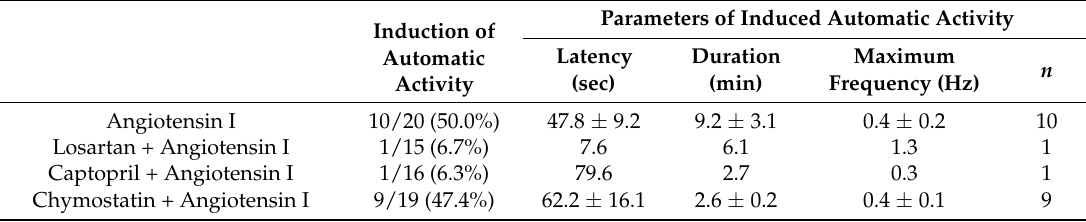
Figure 2. Induction of automatic contractile activity by angiotensin I in pulmonary vein tissue preparations. ( A ) Typical contractile records on application of 1 μM angiotensin I alone (a), in the presence of 10 μM losartan (b), in the presence of 1 μM captopril (c), in the presence of 10 μM chymostatin (d); ( B ) Summarized time course of the frequency of contraction induced by 1 μM angiotensin I. The 0 min on the time scale indicates the onset of contractile activity. Symbols and vertical bars indicate the mean ± S.E.M. from 8 experiments; ( C ) Summarized results of the rate of induction of automatic contractions by angiotensin I. Columns indicate the rate of induction from 15 to 20 experiments. Asterisks indicate significant difference from the control ( p < 0.05) as evaluated by the Fisher’s exact test. Table 2. Induction of automatic contractile activity by angiotensin I.